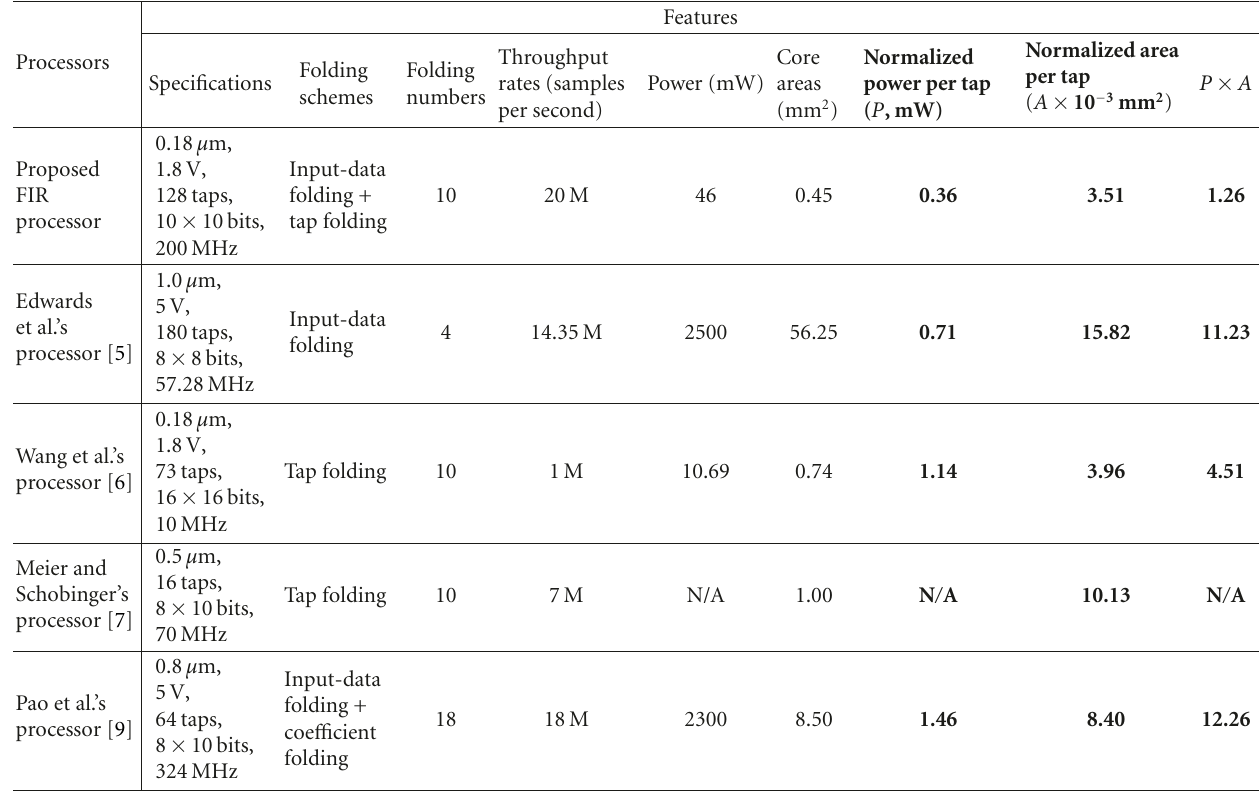
Table 3: Comparison of the proposed and conventional programmable FIR